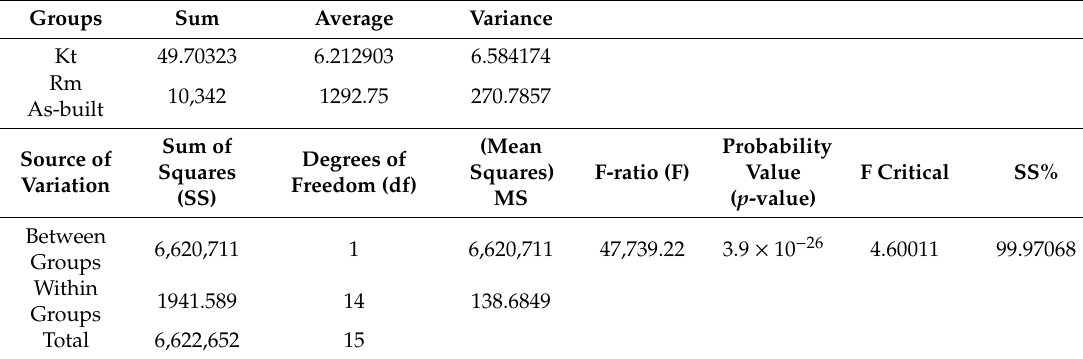
Table A8. ANOVA: Single Factor As-built condition.